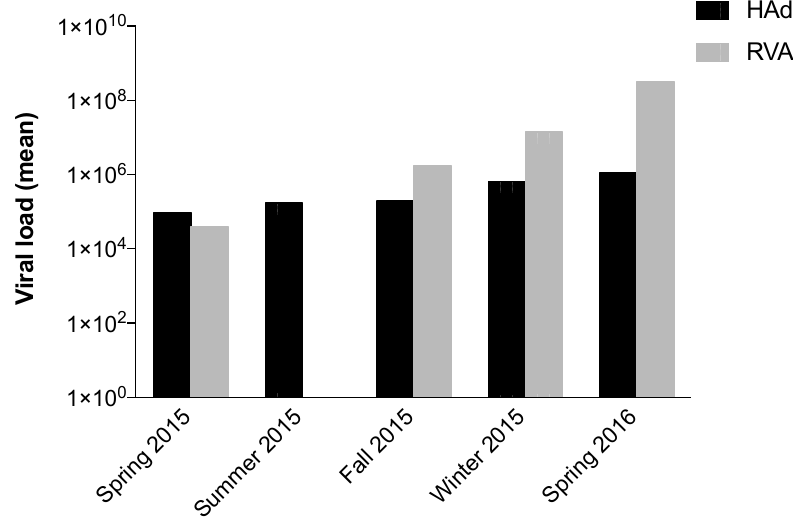
Figure 2. Human adenovirus (HAdV) and rotavirus A (RVA) circulation in raw sewage samples by season. Seasonal distribution of HAdV and RVA detected by qPCR and RT-qPCR, respectively, in raw sewage samples collected between spring 2015 and spring 2016 in Catalonia.